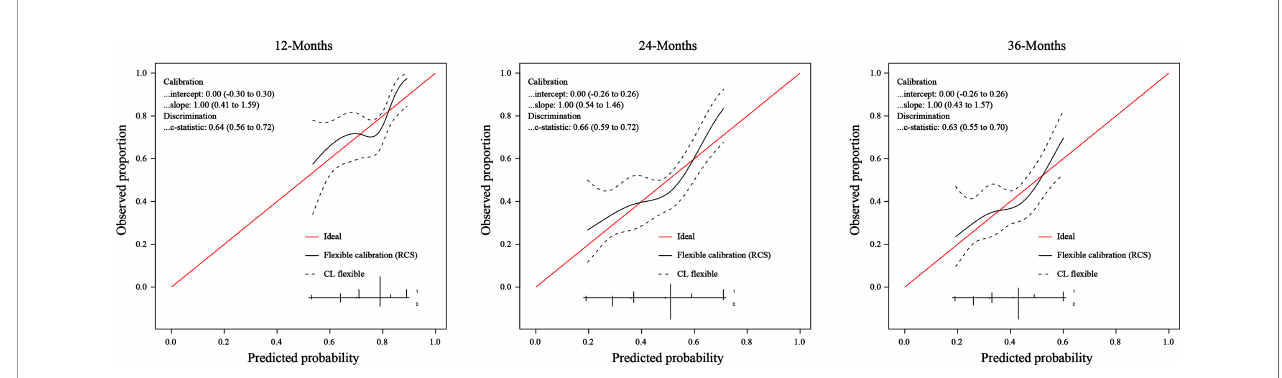
FIGURE 4 | The calibration curve of the nomogram for predicting SCLC patients ’ 1-, 2-, and 3- year